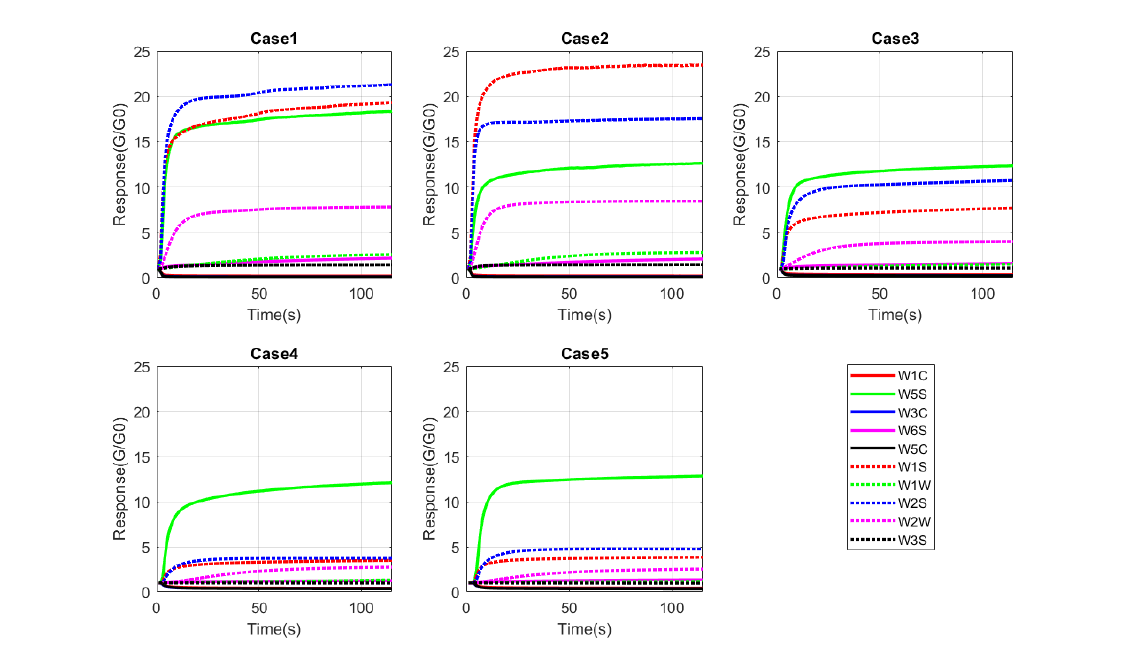
Figure 7. Sensory responses to the five